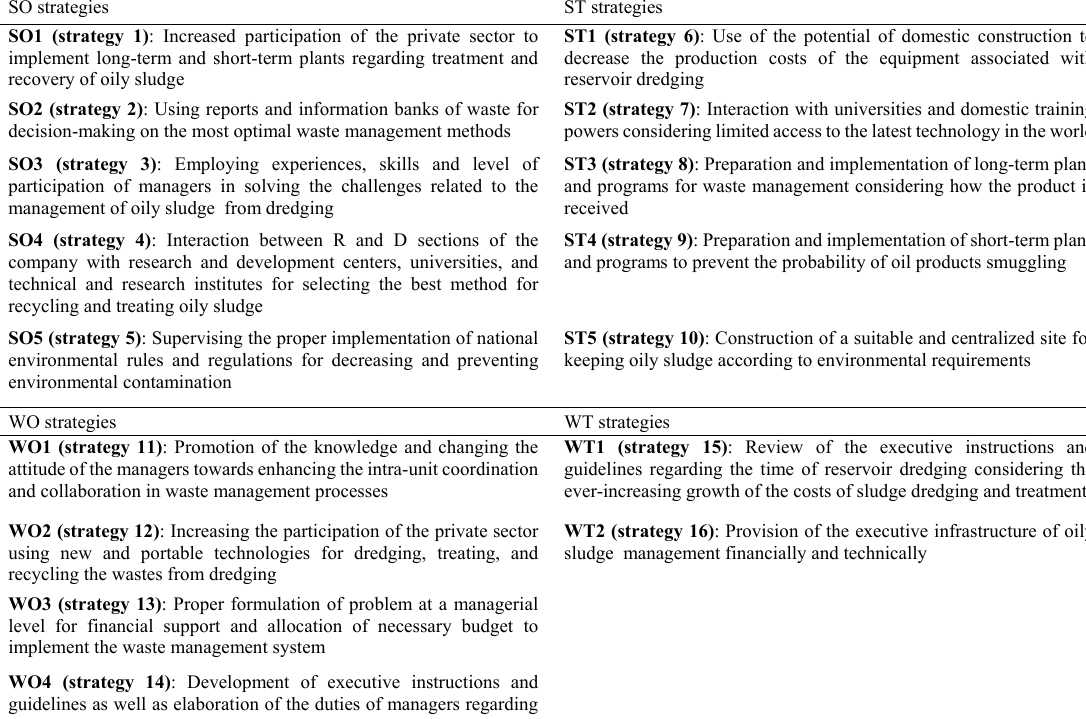
Table 3: Strategies for improving the executive management of oily sludge